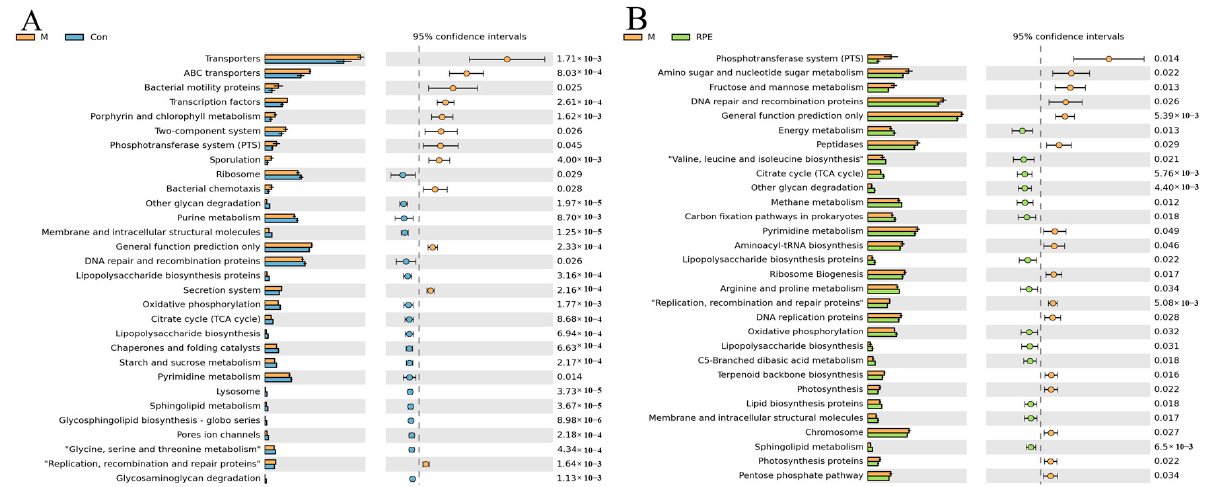
Figure 6. Function prediction of the gut microbiota revealed by PICRUSt2. M group versus Con group ( A ) or RPE group ( B ). Note: p < 0.05, confidence intervals =